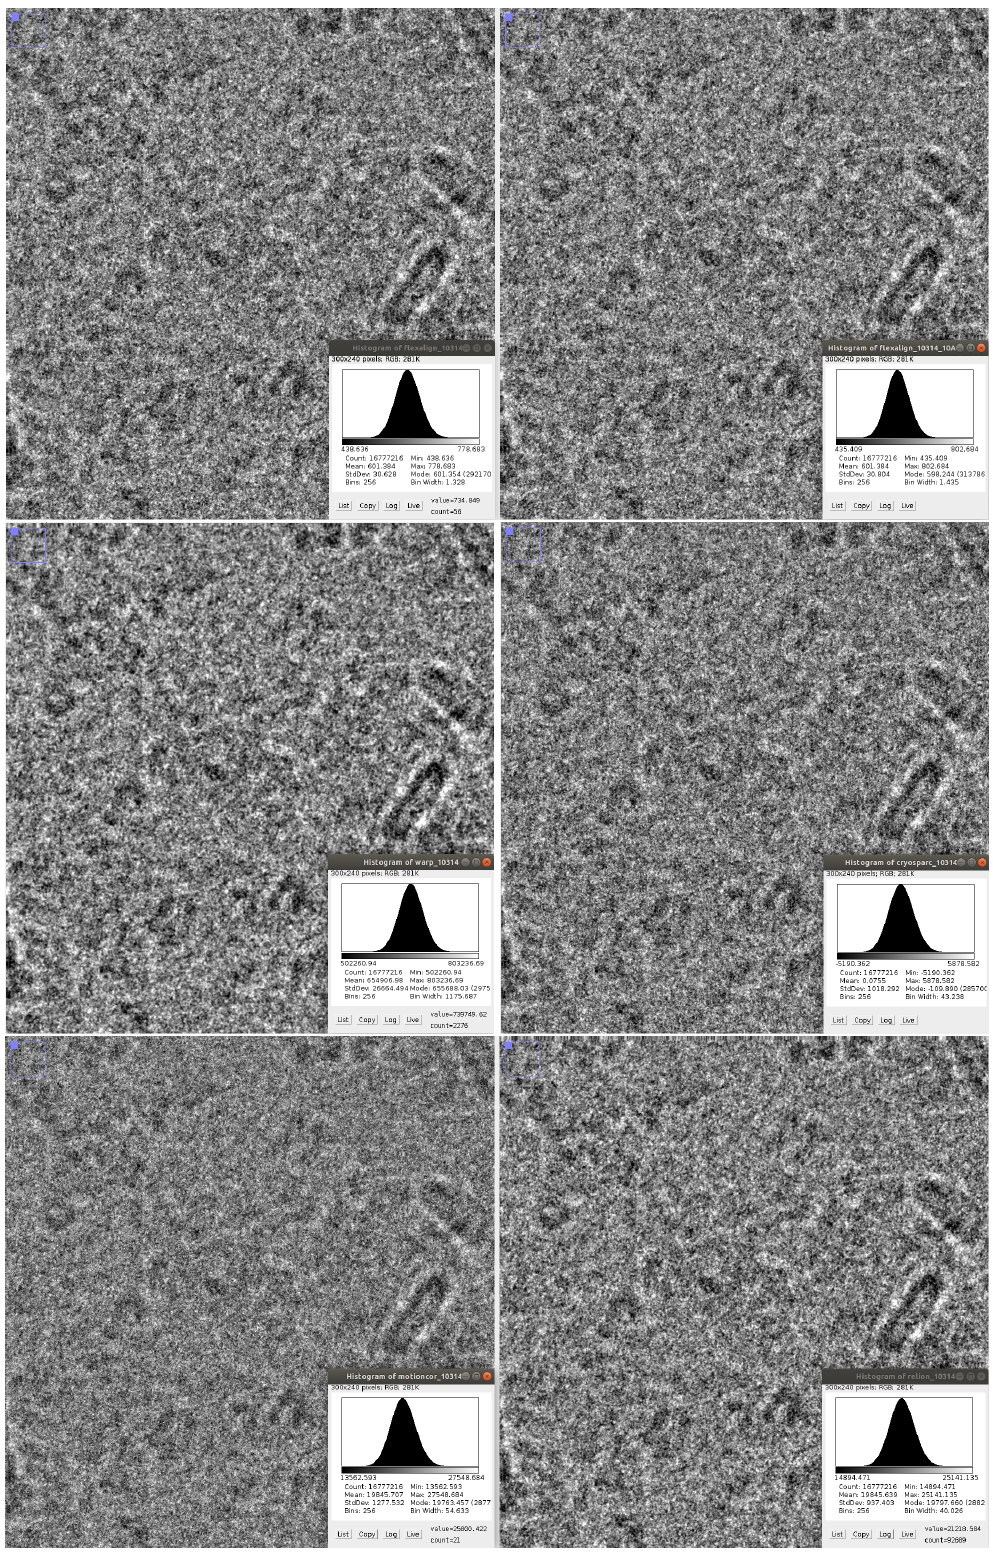
Figure 12. Details of the produced micrograph using EMPIAR 10314 dataset (normalized) with histogram (before normalization): FlexAlign ( top left ), FlexAlign with low-pass filter at 10 Å ( top right ), Warp ( center left ), cryoSPARC ( center right ), MotionCor2 ( bottom left ), Relion MotionCor ( bottom right